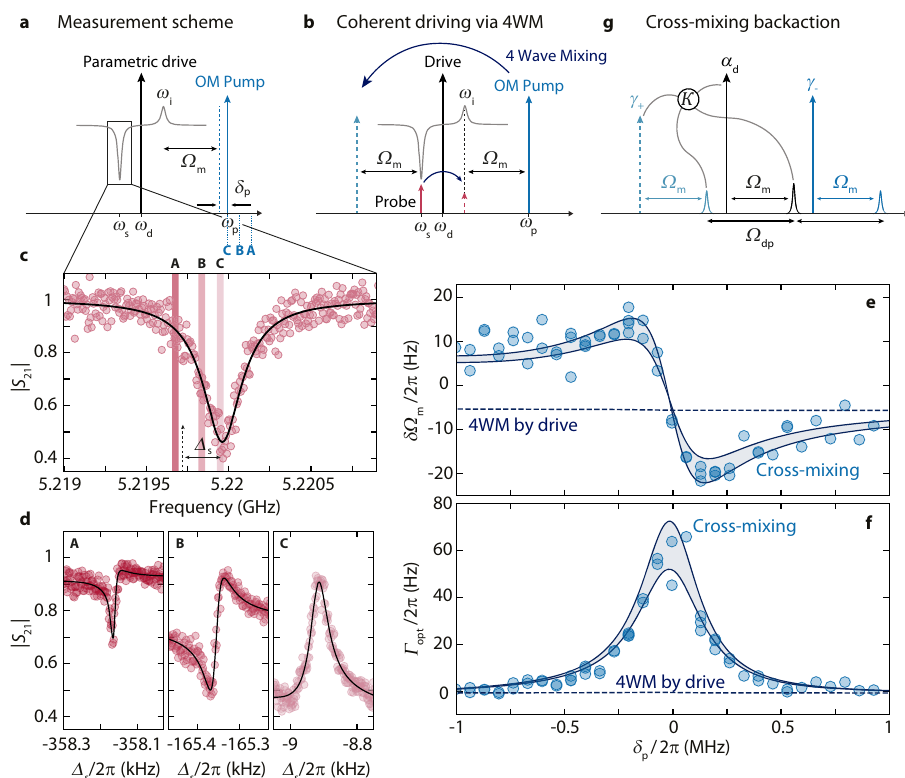
Fig. 3 Four-wave OMIT and four-wave backaction for optomechanical blue-sideband pumping of the idler quasi-mode. a Experimental protocol. The SQUID cavity is prepared in the quasi-mode state by a strong parametric drive (PD). In addition, an optomechanical (OM) pump tone is applied on the blue sideband of the idler resonance (IR) ω p = ω i + Ω m + δ p . Finally, we use a weak probe tone around the signal resonance (SR) to detect optomechanically induced transparency. We repeat this scheme for varying detunings δ p . b explains how this protocol to the fi rst order leads to coherent driving of the mechanical oscillator. By PD-induced intracavity 4WM, the OM pump (probe tone) gets an idler fi eld on the opposite side of the drive, which has the right detuning to the probe tone (pump) ~ Ω m to coherently drive the mechanical oscillator. c shows the signal resonance transmission S 21 measured with the weak probe fi eld (OM pump off). Circles are data, line is a fi t. Vertical bars labeled with A, B, and C indicate zoom regions for the corresponding panels shown in c and Δ s = ω − ω s denotes the detuning between probe fi eld and SR. d Probe tone response (OM pump on) in three narrow-frequency windows around ω ≈ 2 ω d − ω p + Ω m for three different pump detunings δ p , cf. panel a . Note that the frequency difference between OM pump and probe fi eld is Ω ≈ Ω − 2 Ω fi eld frequency is reduced, the probe- fi eld frequency is increasing. Each probe-tone response displays a m dp , which implies that when the pump- narrow-band resonance, indicating optomechanically induced transparency (OMIT) via excitation of the mechanical oscillator. For each δ p , we fi t the OMIT response (lines in c ) and extract the effective mechanical resonance frequency Ω eff = Ω m + δΩ m and the effective mechanical linewidth Γ eff = Γ m + Γ opt . The contributions δΩ m and Γ opt , induced by dynamical backaction of all intracavity fi elds, are plotted in panels e and f as circles vs δ p . The result of analytical calculations is shown as two solid lines with shaded area, where the range described by the lines captures uncertainties in the device parameters, cf. Supplementary Note 11. The dashed line shows the result of equivalent calculations without cross-mixing (nondegenerate 4WM) terms. g illustrates schematically one four-wave cross-mixing term that leads to the observed dynamical backaction. Hereby, two mechanical sidebands with frequency difference Ω dp = ω d − ω p and both, the PD and the OM pump, contribute to the interaction. For the data in c – f , B ∥ = 21 mT, g 0 = 2 π ⋅ 1.75 kHz, and n d ≈ 69 ±